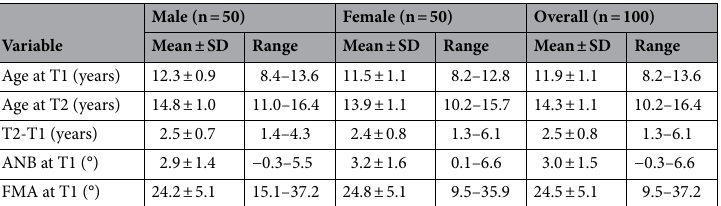
Table 1. Descriptive statistics of patient variables. SD: Standard deviation. ANB: ANB angle. FMA: Frankfort- mandibular plane